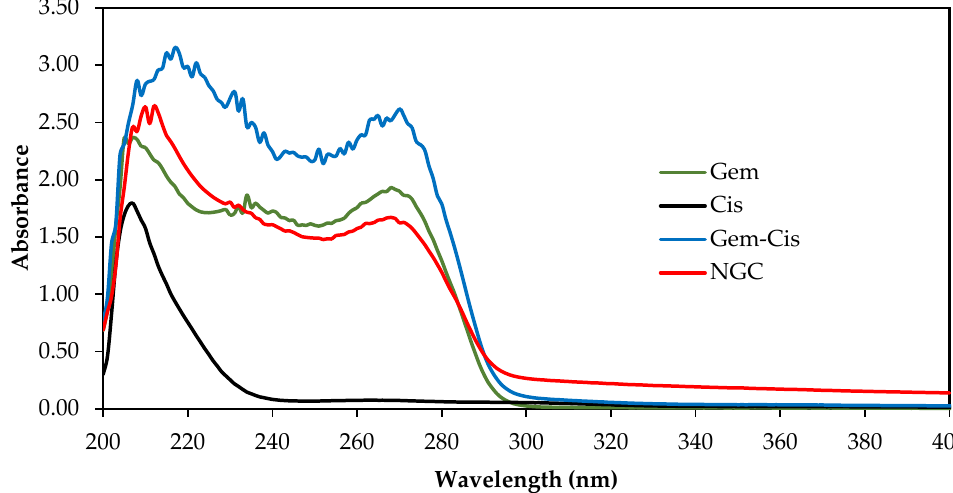
Figure 4. UV–visible spectra of Gem, Cis, Gem–Cis, and the optimized NGC.